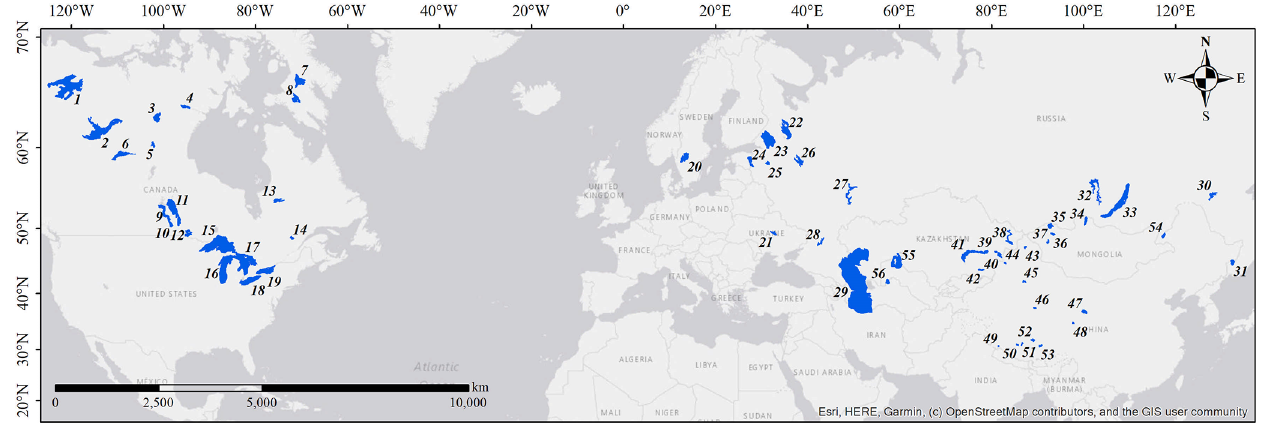
Figure 1. Location of the 56 study lakes (the names of the lakes are listed in Table 1). © OpenStreetMap contributors 2021. Distributed under the Open Data Commons Open Database License (ODbL)